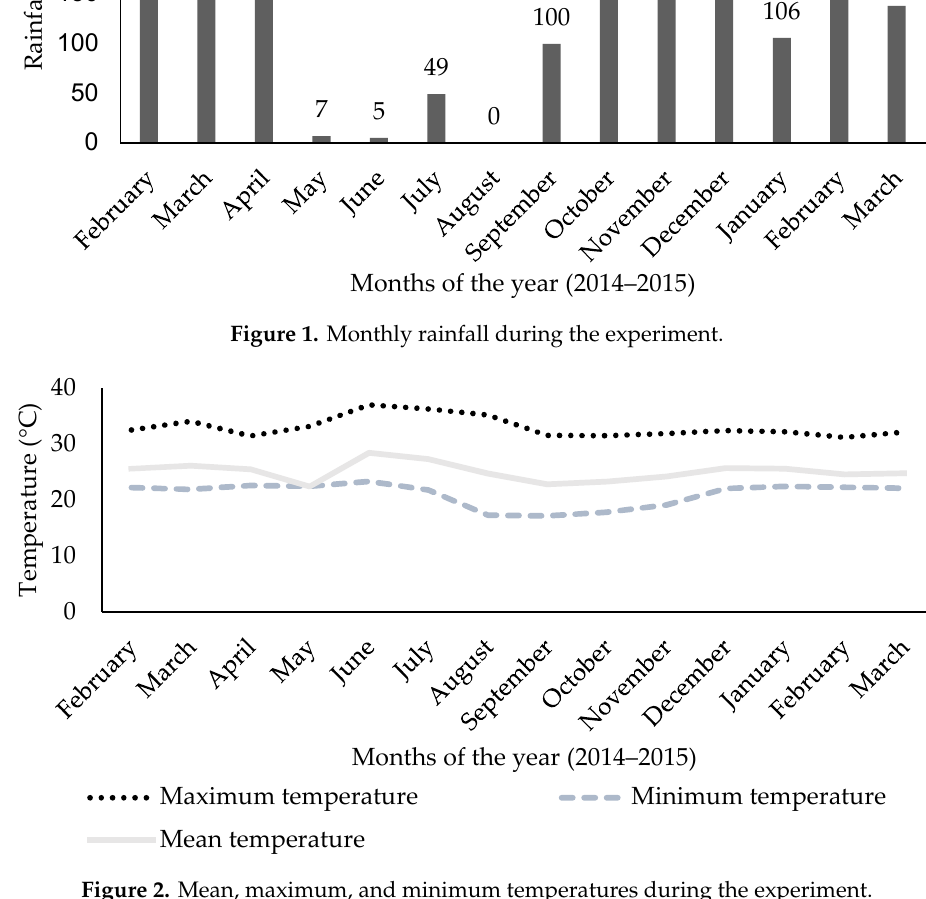
Figure 2. Mean, maximum, and minimum temperatures during the experiment.